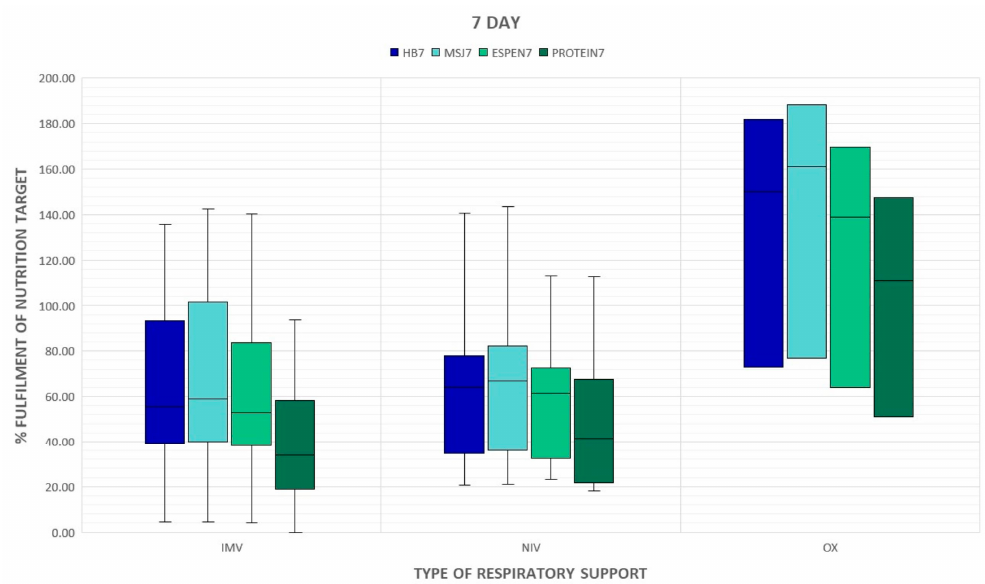
Figure 2. Type of respiratory support at the ICU admission and delivery of energy and proteins on